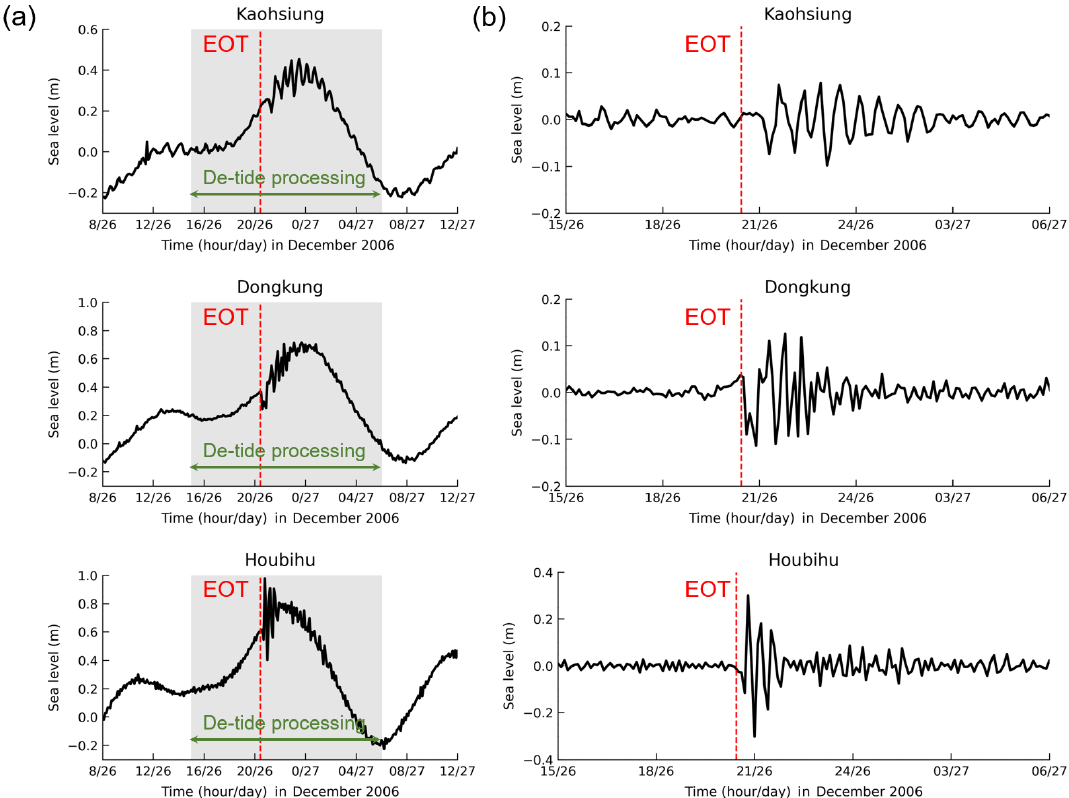
Figure 3. The (a) original and (b) de-tided sea levels recorded at tide gauge stations in southern Taiwan during the 26 December 2006 tsunami event. The vertical, dashed red lines indicate the earthquake occurrence time (EOT). The gray shaded areas illustrate the tide gauge data used for de-tide processing. The data shown in the graphs were drawn based on national standard